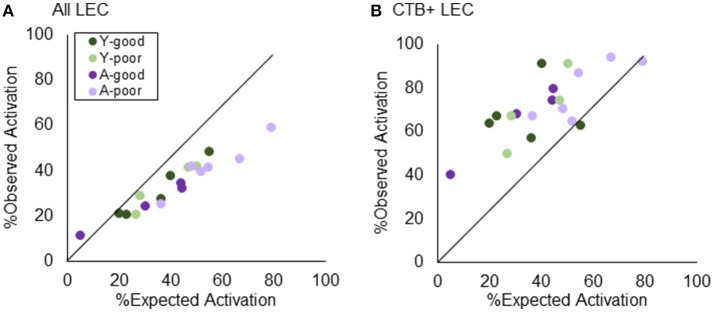
Testing “Uniform Random Draw with Replacement” in LEC. Revisiting the nature of neurons being utilized redundantly across environments, layer II LEC neurons were quantified in terms of their observed vs. expected distribution of active cells. (A) When the analysis encompassed all layer II LEC neurons, the expected activation outweighed the observed, suggesting that more LEC neurons are activated during both epochs of exploration than what is expected by chance. (B) Restricting the analysis to the LEC→CA3 projection neurons, however, demonstrates the opposite effect. The observed % of active neurons outweighs the expected, suggesting a dissimilar pattern across environments beyond what has normally been explained as “chance.”